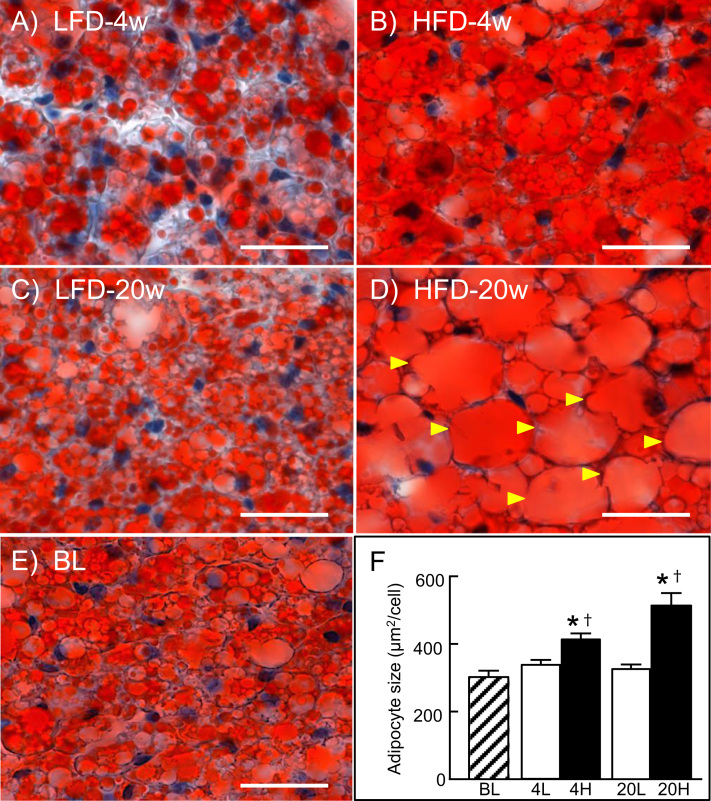
Oil Red O staining of BAT sections. Sections were prepared from C57BL/6J mice fed a LFD for 4 (A) or 20 weeks (C), or a HFD for 4 (B) or 20 weeks (D), or baseline (E). In D, arrowheads indicate cells containing unilocular large lipid droplet. Scale bars, 20 µm. (F) Quantitative analysis of adipocyte size, expressed in µm2. Areas were calculated from 50 adipocytes of 5–8 mice in each group. Result are mean±SEM. *p<0.05 vs. baseline; †p<0.05 vs. the LFD group at the same feeding time period.